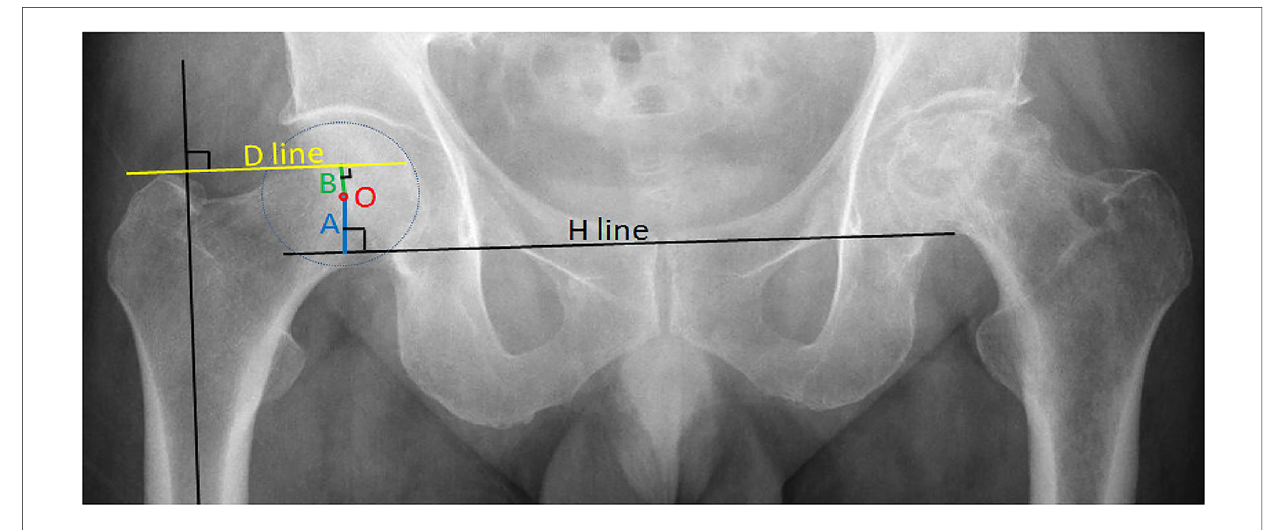
FIGURE 1 Preoperative measurement of a healthy hip: A is the height of the acetabulum, and B is the height of the femoral